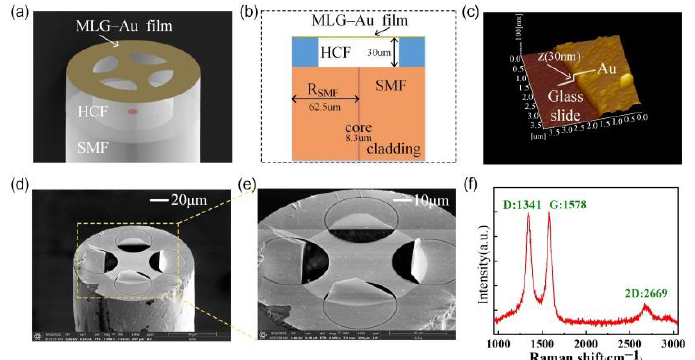
Figure 1. ( a ) Schematic of the membrane-based fiber optic resonator. ( b ) Schematic of side view of the optomechanical resonator. ( c ) Schematic diagram of the glass slide used to measure the thicknesses of the Au film. ( d ) SEM image of the trampoline graphene – Au membrane. ( e ) Enlarged partial view of figure ( d ). ( f ) Raman spectrum from the suspended multilayer graphene (10 – 15 layers) measured using a 532 nm laser.